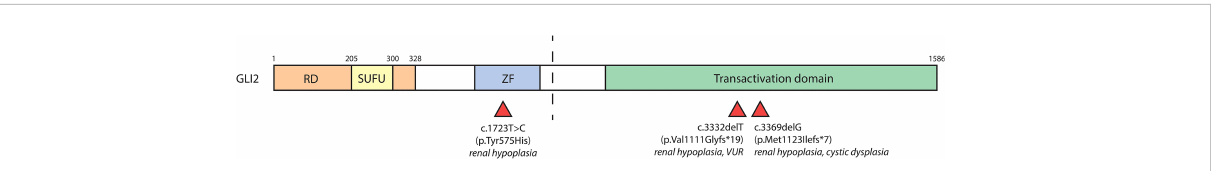
FIGURE 4 GLI2 variants associated with CAKUT. The human GLI2 protein is comprised of a repressor domain (RD, a.a. 1-328), SUFU-binding domain (SUFU, a.a. 205-300), zinc fi nger DNA-binding domain (ZF) and C-terminal transactivation domain. The zinc fi nger and transactivation domains of GLI2 have not been well positionally de fi ned. The dashed line indicates the site of proteolytic cleavage that results in formation of GLI2R. Red triangles underneath denote location of GLI2 variants and their associated renal